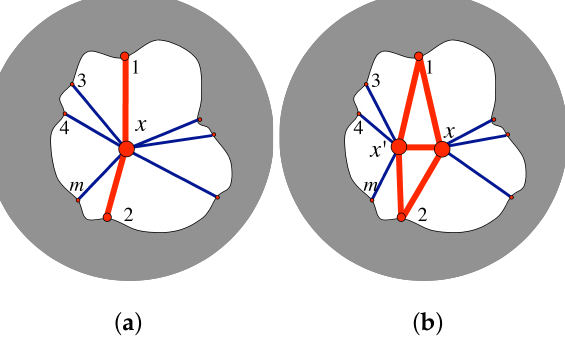
Figure 64. Given a pair of edges from a shared vertex ( a ), a vertex split opens this up to a pair of triangles, with one new vertex ( b ). If we are working in part of a triangulated surface, this expands the triangulated surface, preserving infinitesimal rigidity in 3-space. Under appropriate conditions, we can contract such a shared edge to find a smaller infinitesimally rigid framework